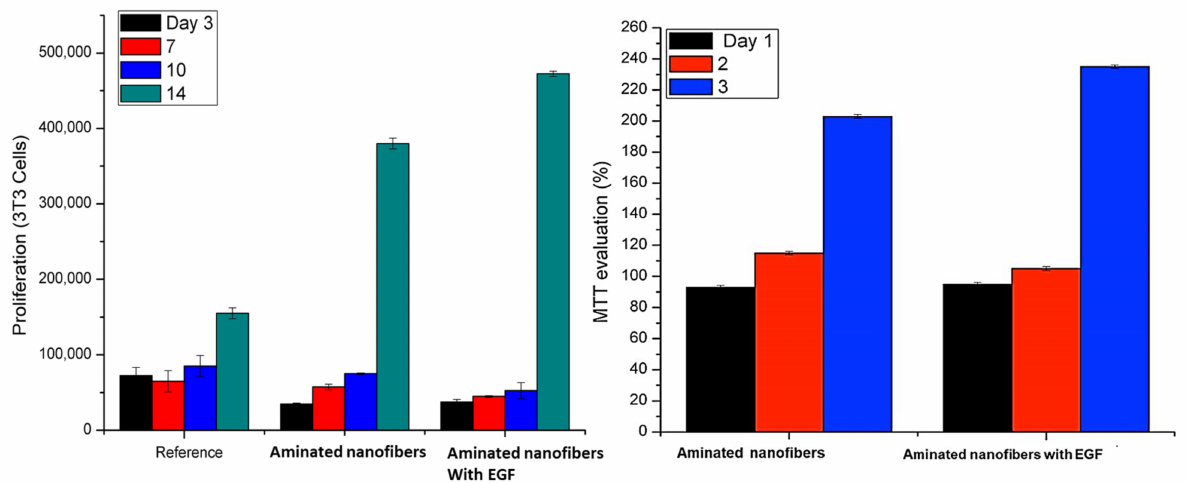
Figure 6. Mouse fibroblast (3T3) biocompatibility ( a ) and cell Proliferation MTT (3 days) ( b ) Cell counting (14